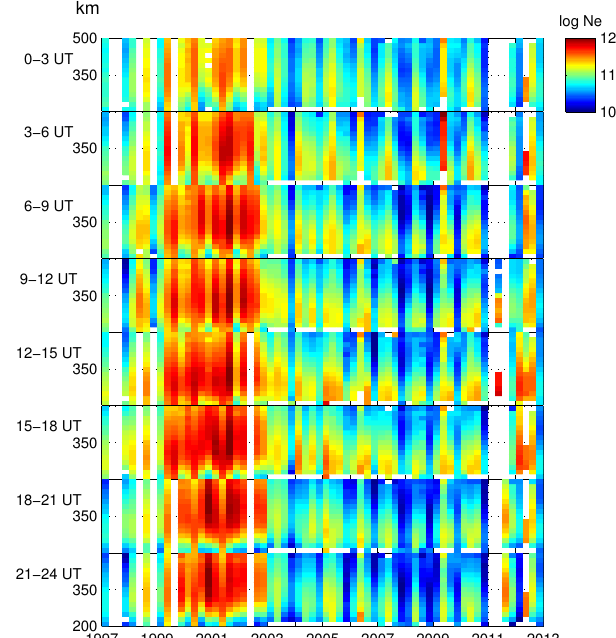
Figure 1. Altitude profiles of electron density (log10 N e ,m − 3 ) measured by ESR and integrated over 3h in a day for 3 months (spring, summer, autumn, winter). Panels correspond to the 3h in- tegration